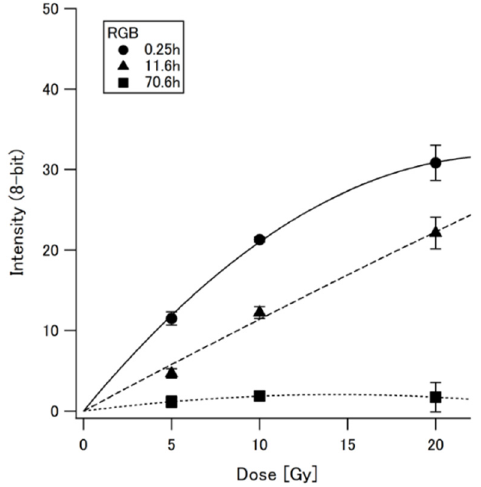
Figure 3. Dose responses of the 8-bit intensities of the inverted images of PAISiN at 0.25 h, 11.6 h and 70.6 h after γ -ray irradiation at room temperature (20 ◦ and 70.6 h after γ -ray irradiation at room temperature (20 °C). and 70.6 h after γ -ray irradiation at room temperature (20 °C).